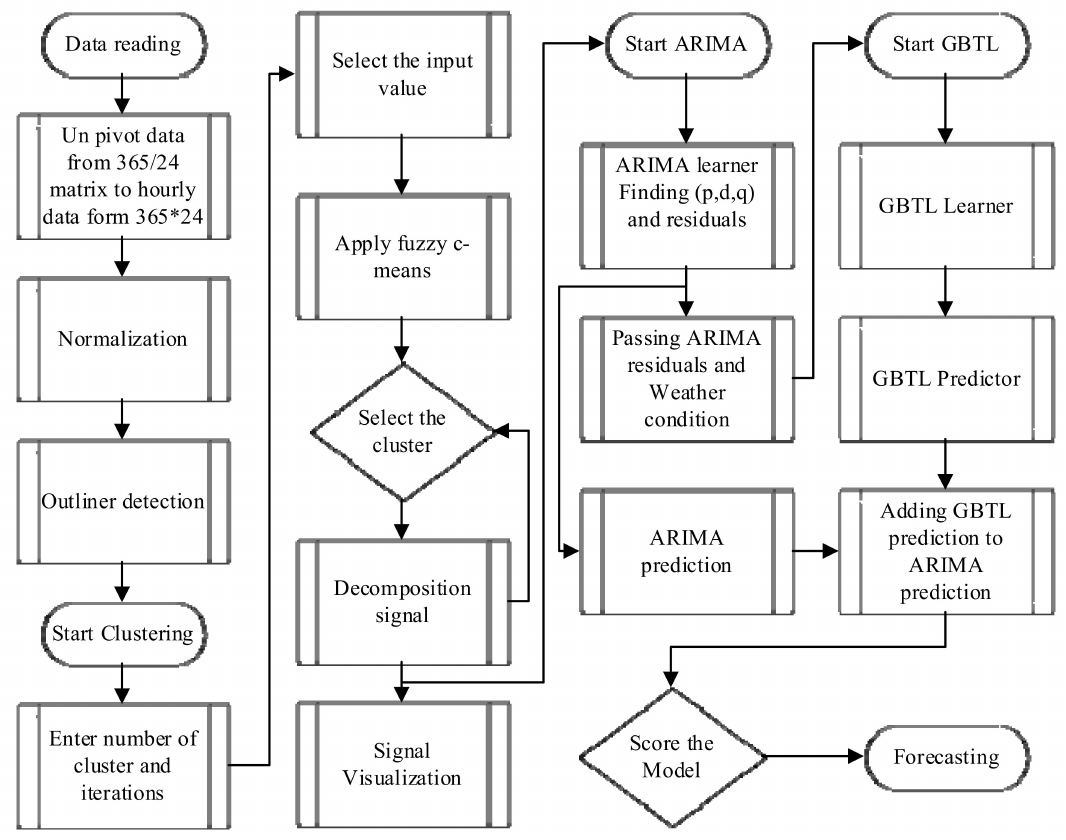
Figure 13. The Proposed